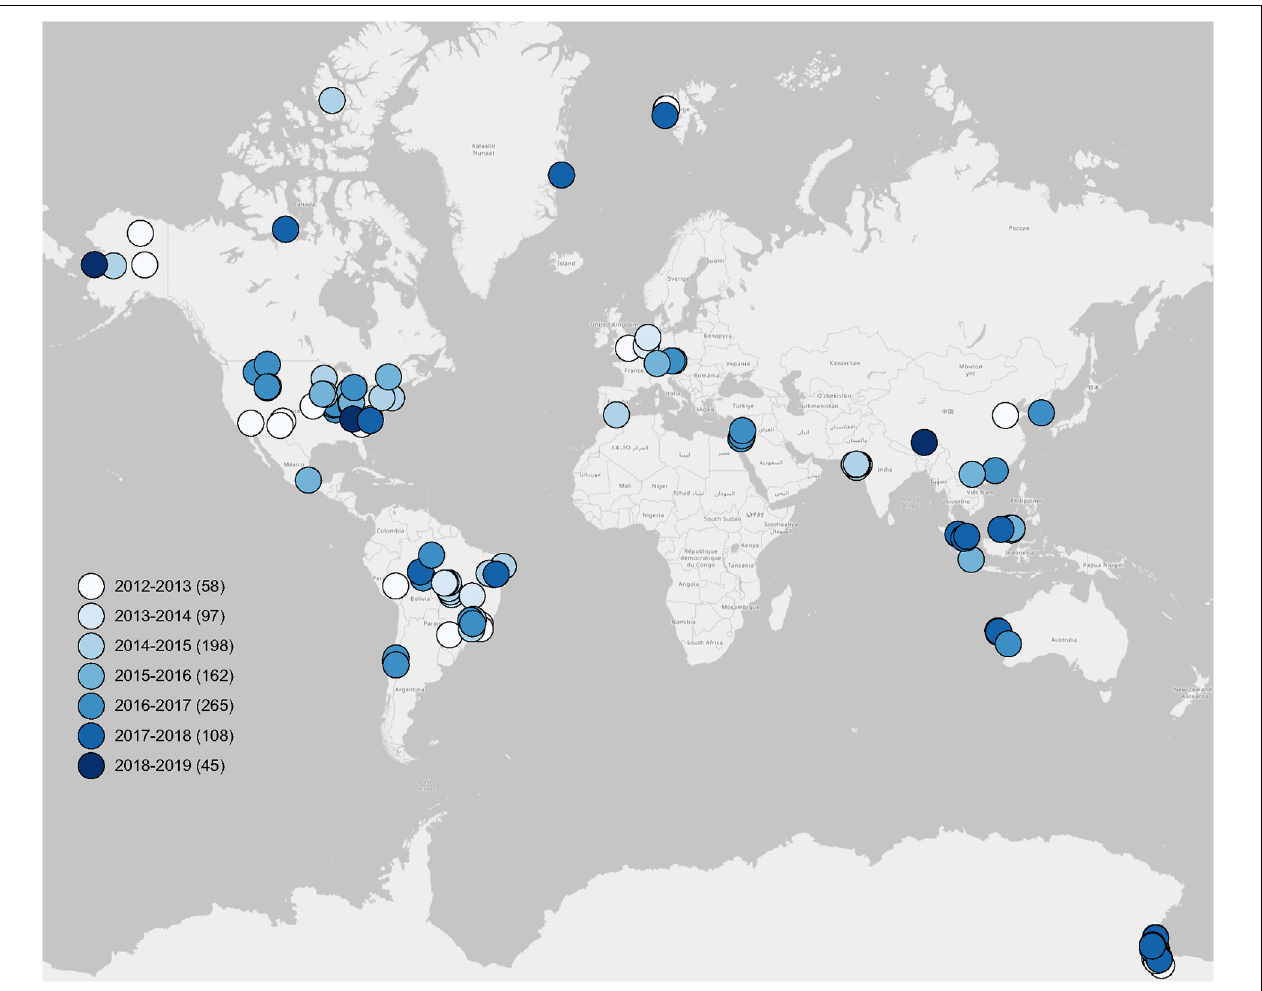
FIGURE 1 | Global distribution of soil metagenomes. Locations of 933 soil metagenomes from 56 publications used in this study. Legends show seven groups of publication periods. Sample sizes of each group are given in parentheses.